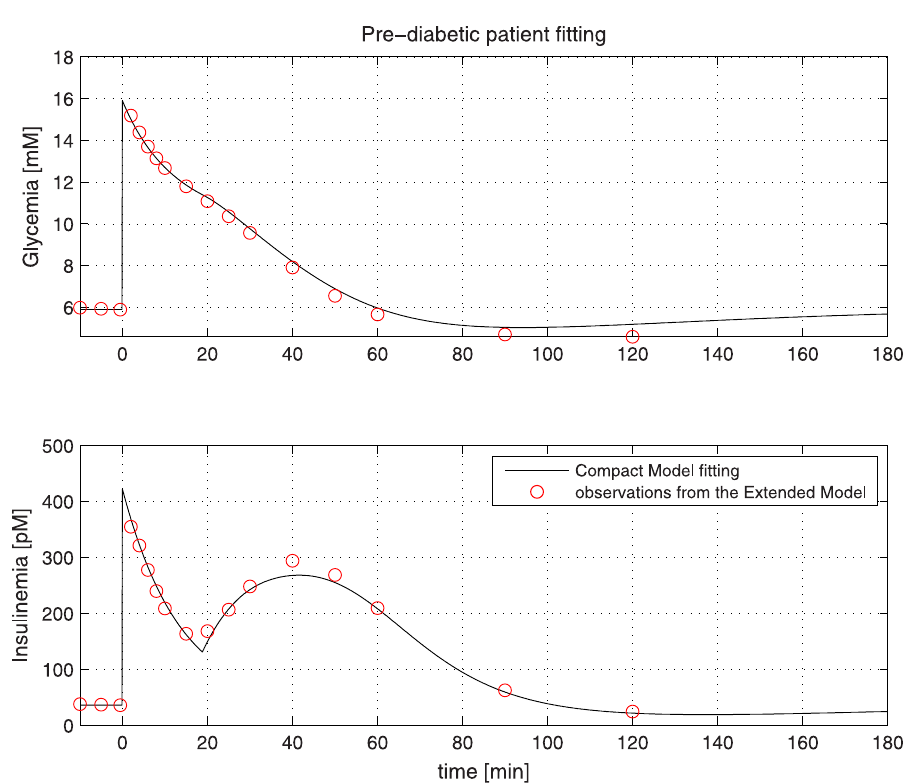
Fig 5. Observations extracted from a virtual prediabetic patient undergone an IVGTT (red dots). The black line represents the Compact Model fitting.